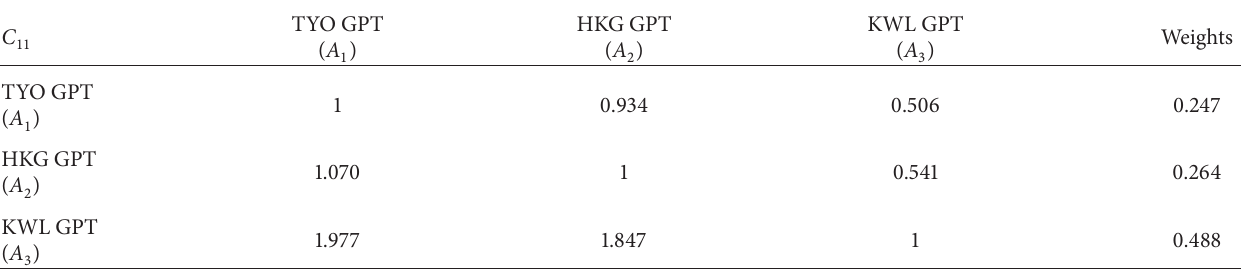
Table 8: Pairwise comparison matrices for subcriteria ( C 11 ) to compute the weights of three alternatives.